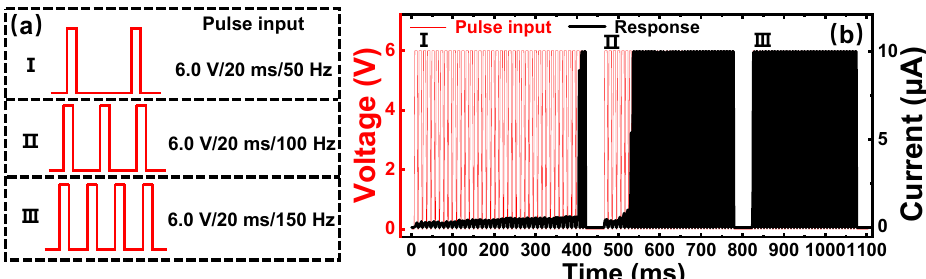
Figure 5. Current response of different frequency of input pulses. ( a ) Trains of pulses with different frequency of 50 Hz (first), 100 Hz (second), and 150 Hz (third). ( b ) Current response of sequential input pulses corresponding to ( a ).